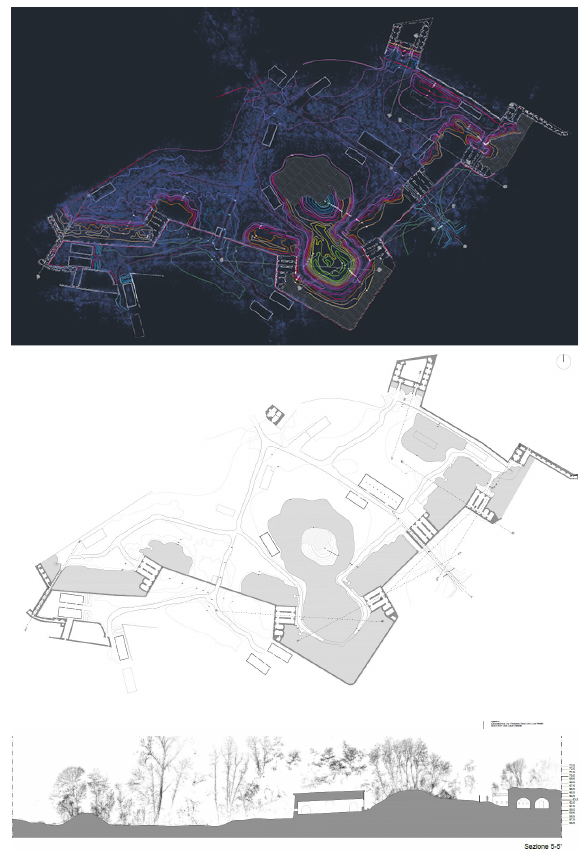
Figure 9. overlay of the Pegasus Backpack point cloud and the digitalization (top), 1:500 plan of the fort and a cross-section